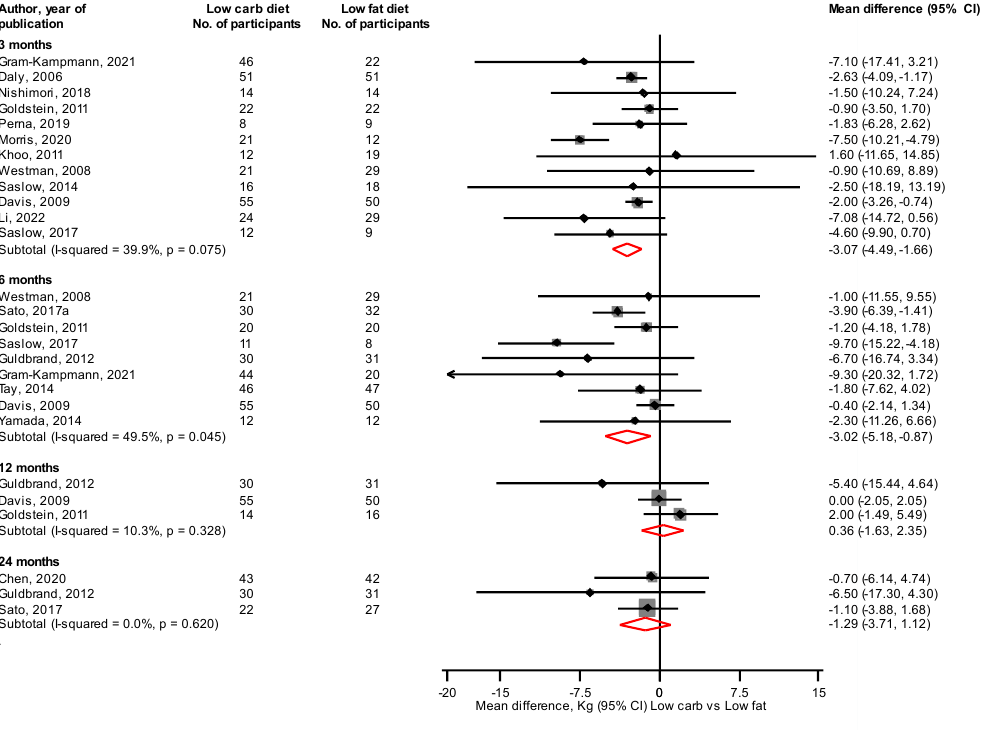
Figure 4. Low carbohydrate versus low fat diet and body weight [31 – 35,38 – 41,43 – 46,48,50 – 53].